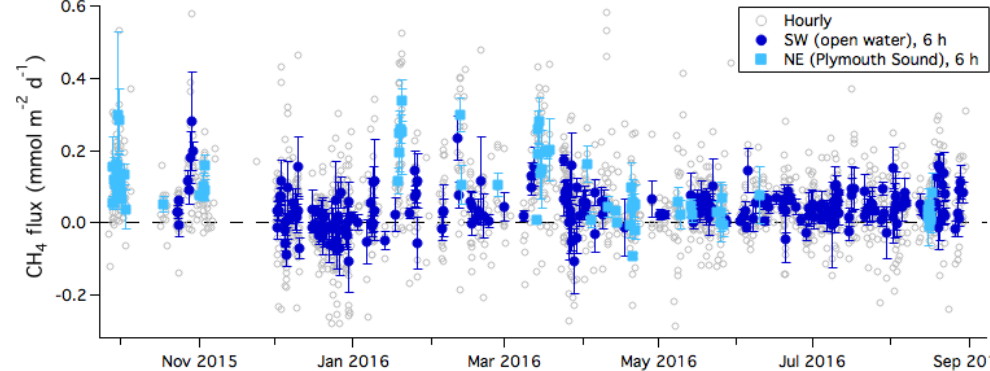
Figure 1. One-year time series of CH 4 flux (hourly average) during times when winds were from the sea. Six-hour averages of fluxes are further separated into the southwest (open water) and northeast (Plymouth Sound) wind sectors. Error bars indicate standard